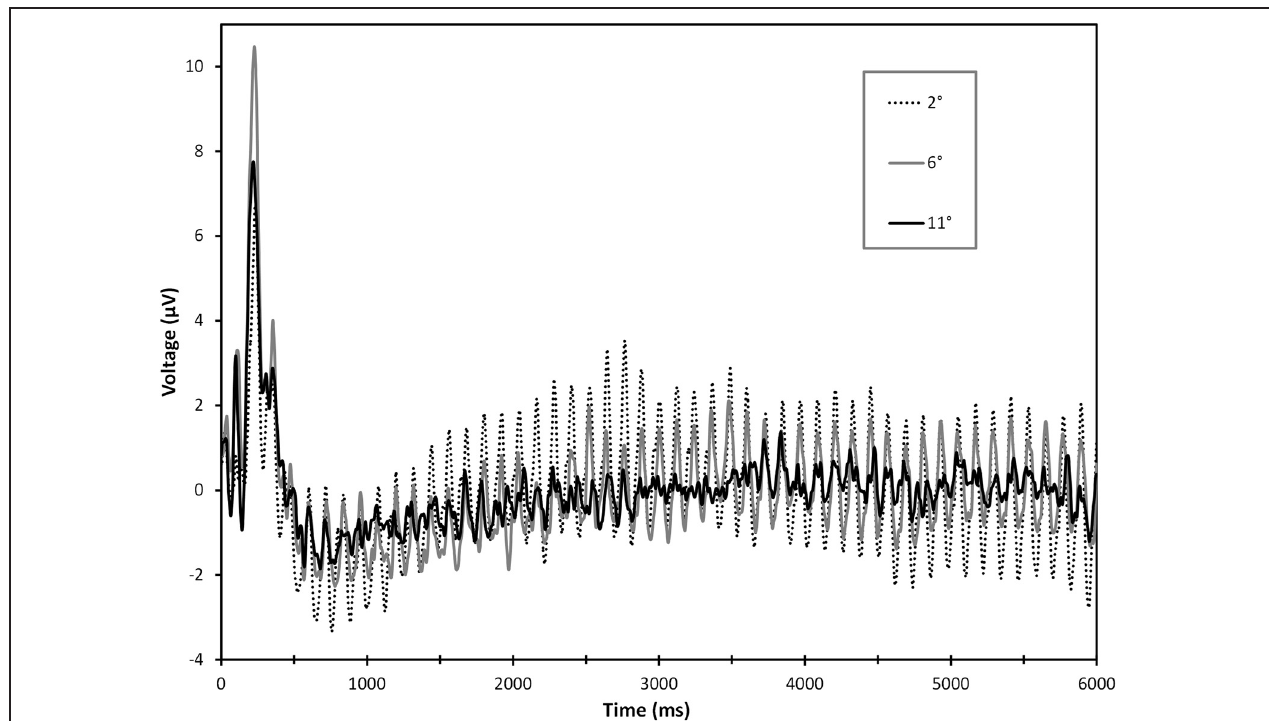
FIGURE 2 | Grand average time-domain responses for 8.3Hz SSVEP responses over the course of a 6.0s trial, collapsed across electrodes O1, Oz, and O2. Notice a large initial transient visual response to the onset of